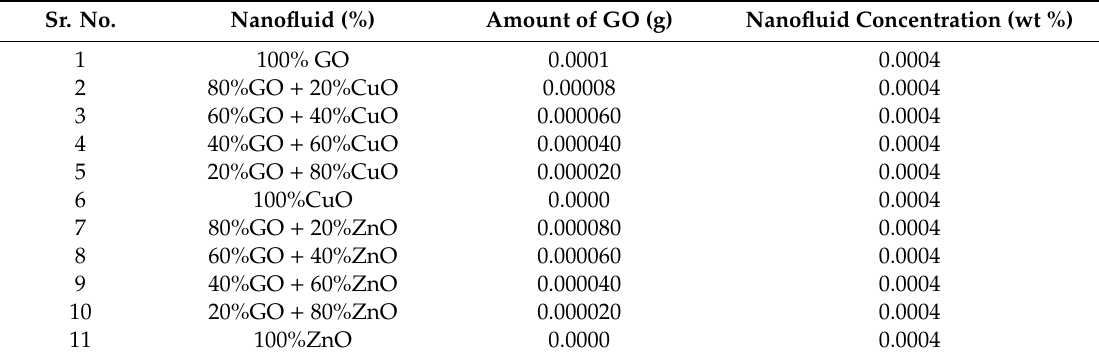
Table 1. Various nanofluids with di ff erent ratios of di ff erent nanoparticles. GO, graphene oxide; CuO, copper oxide; ZnO, zinc